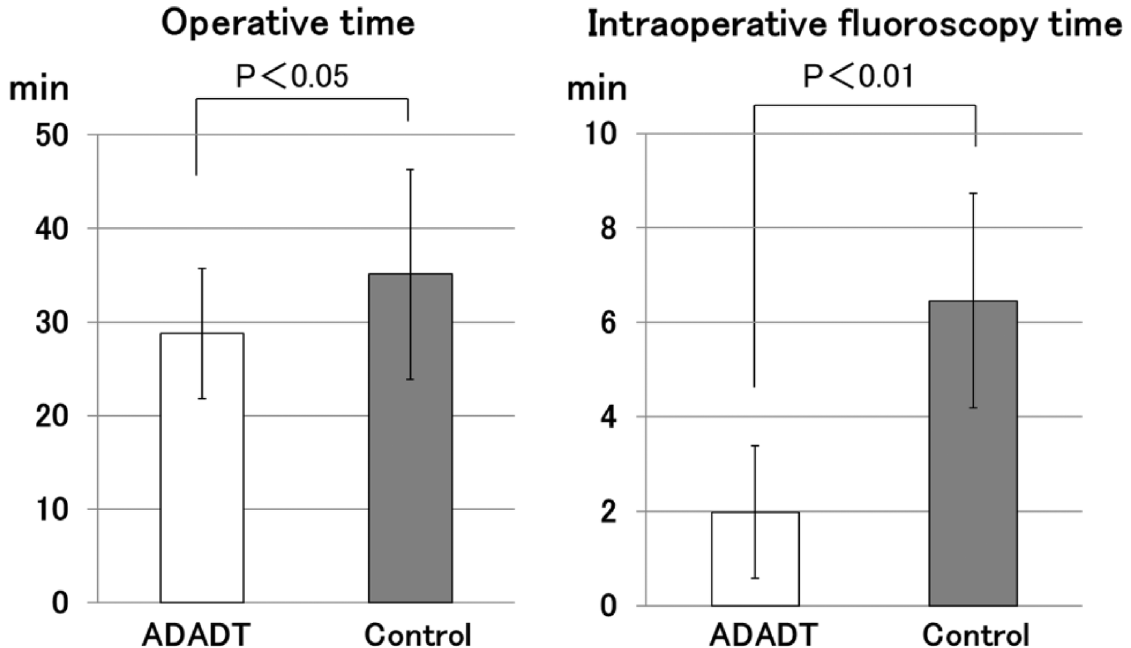
Figure 4. The operative time was signi fi cantly shorter in the ADAPT group. The intraoperative fl uoroscopy time was signi fi cantly reduced in the ADAPT